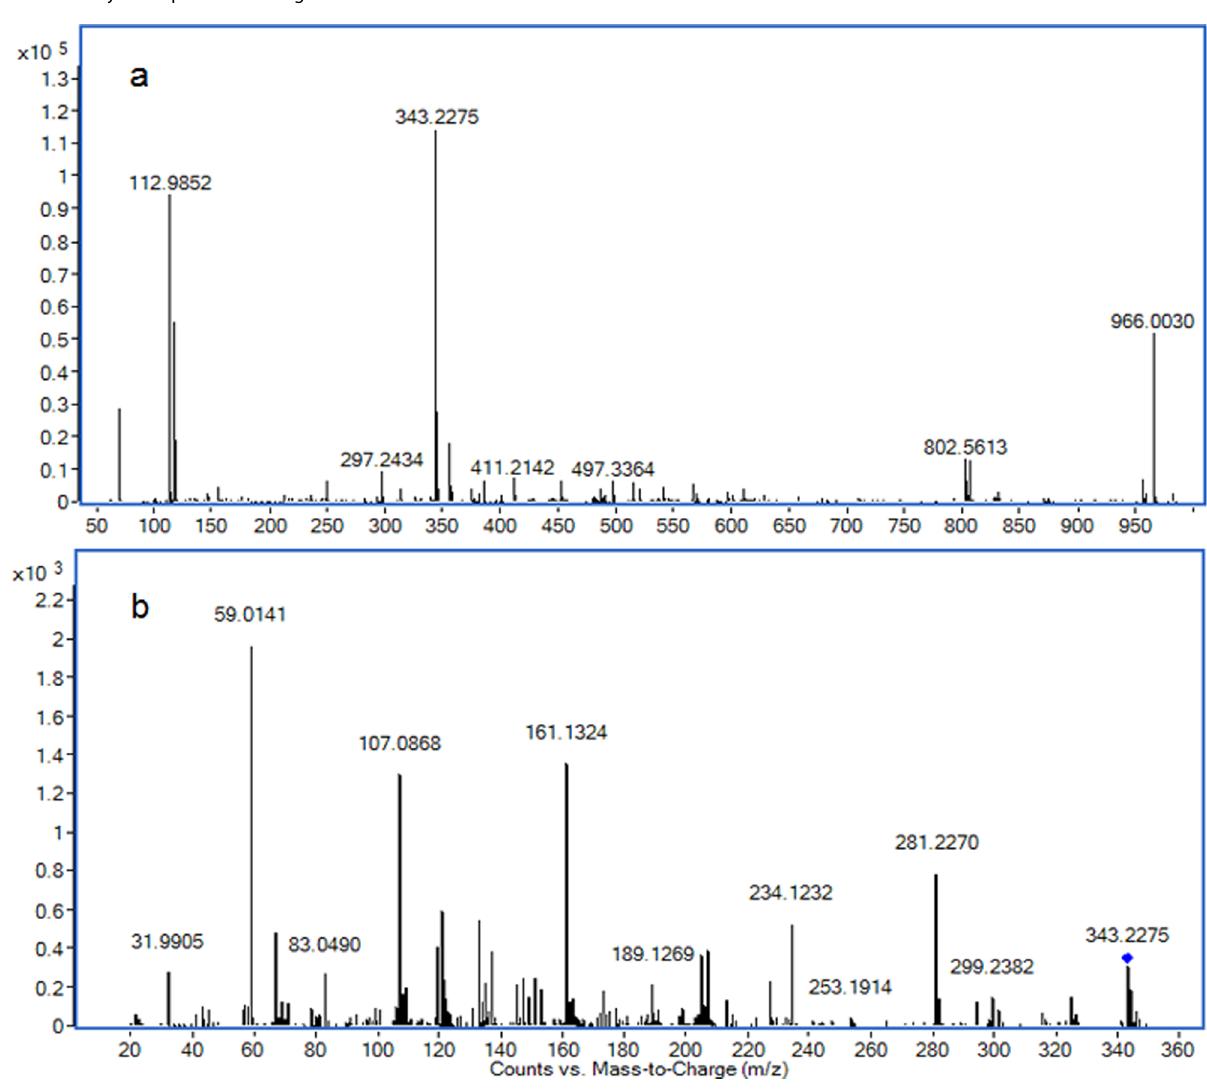
Figure 5. MS (a) and MS/MS (b) information of 14-HDOHE. doi:10.1371/journal.pone.0088223.g005 PLOS ONE |